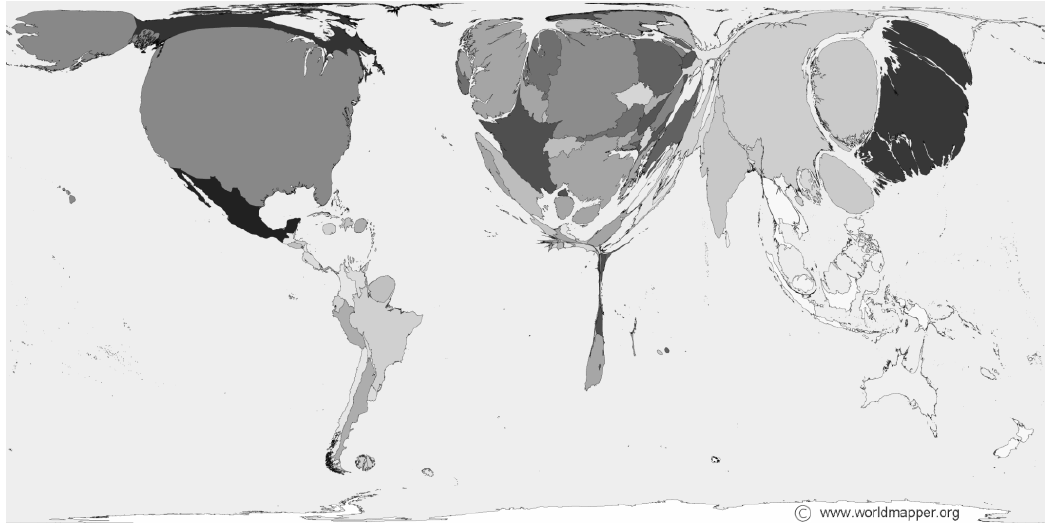
Figure 3. A cartogram showing the number of Internet users in 2002 as published at worldmapper.org [74]. The size of the country is modified to match the number of Internet users. © Copyright SASI Group (University of Sheffield) and Mark Newman (University of